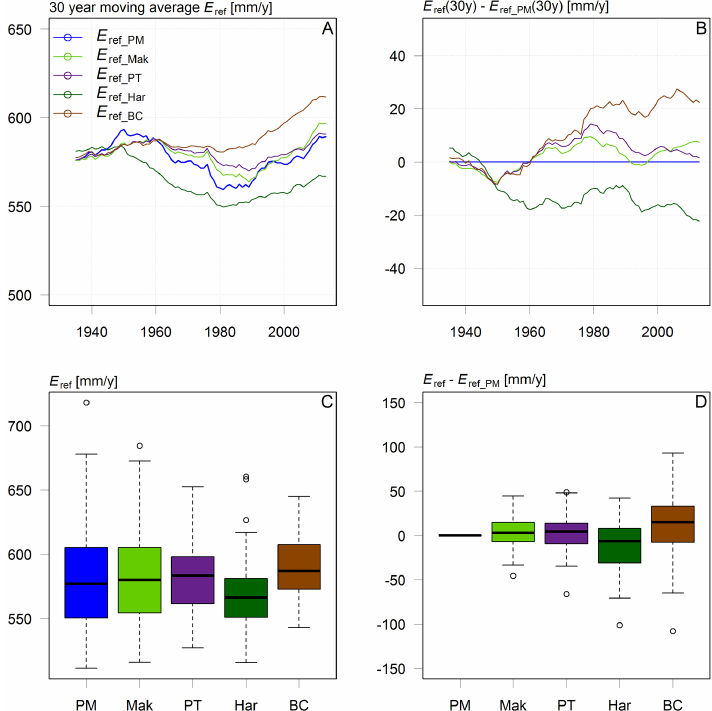
Figure 4. E ref values for five methods for the period 1906–2013. Each empirical method calibrated on daily E ref_PM for the period 1906– 1935. (a) 30-year moving average E ref , and (b) deviation of 30-year moving average E ref from E ref_PM . (c) Yearly variability in E ref for each method. (d) Yearly deviation of each E ref with E ref_PM . The boxplots show the minimum, first quartile, median, third quartile, maximum and outliers of the annual data.